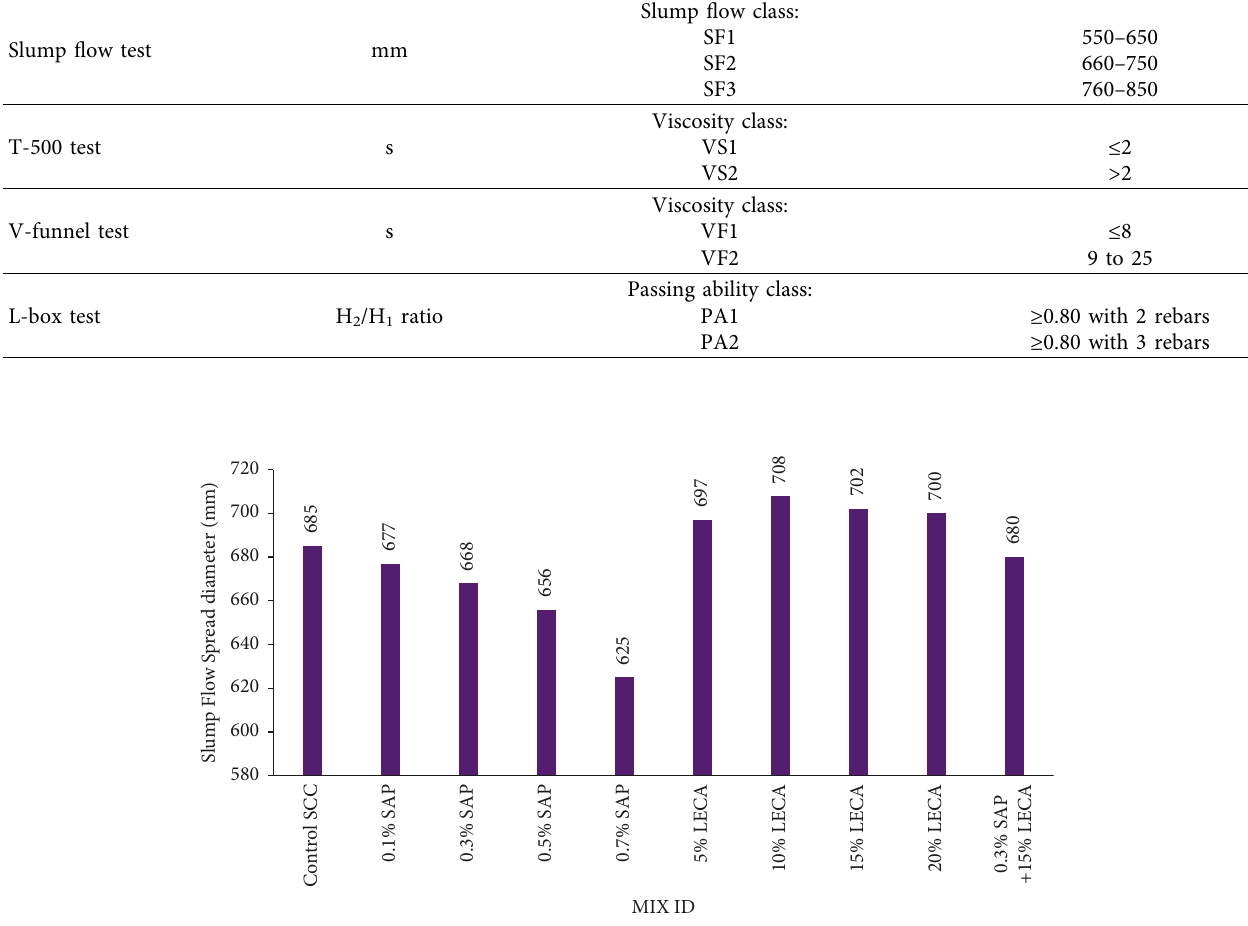
Figure 7: Slump flow spread diameter of all SCC mixes.